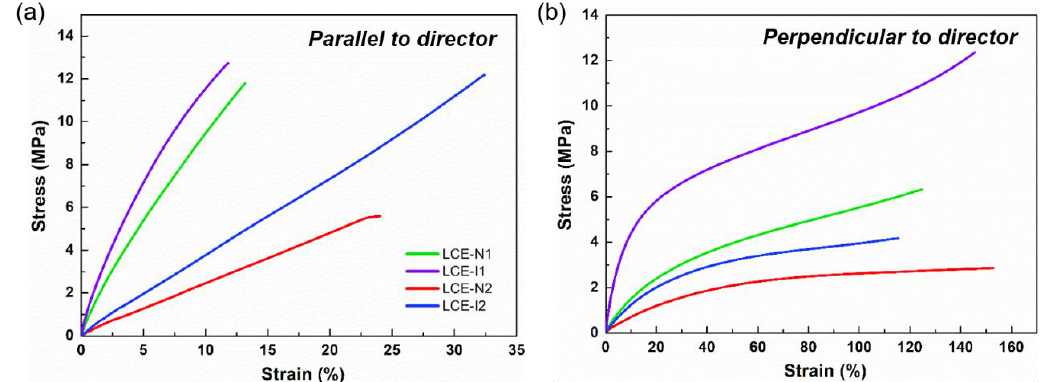
Figure 5. Stress-strain curves of LCEs. Tensile stress was applied ( a ) along the director and ( b ) perpendicular to the director of the LCEs.